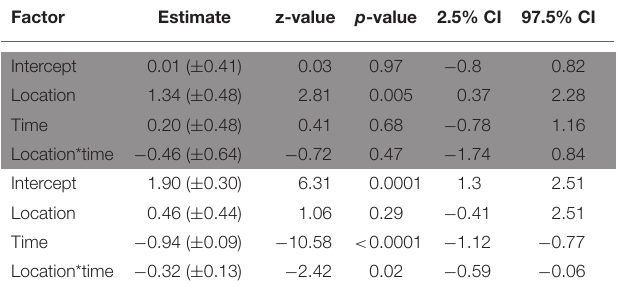
TABLE 3 | Location, time, and interaction effects on sperm viability, determined by a generalized linear mixed model for the non-blind standard experiment with Cimex lectularius (area highlighted in gray, n =